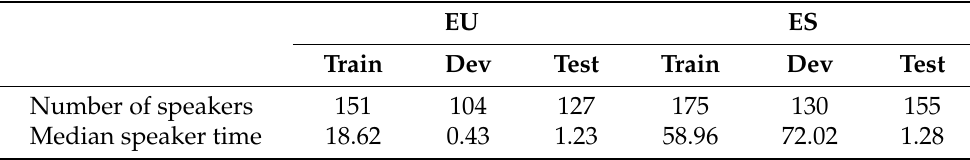
Table 7. Number of speakers and median speaker times